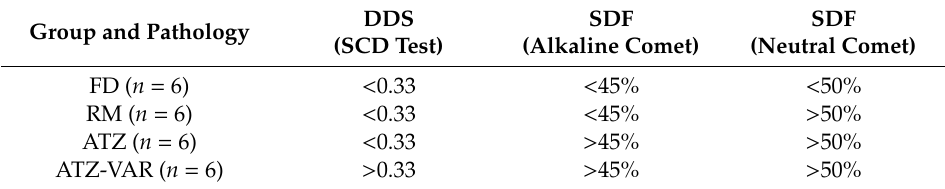
Table 3. Characteristics of patients for 2D-di ff erential gel electrophoresis (2D-DIGE) analysis selected by pathology, DNA degraded sperm (DDS), and Sperm DNA fragmentation (SDF) values 1 , measured by SCD test and Comet assay,